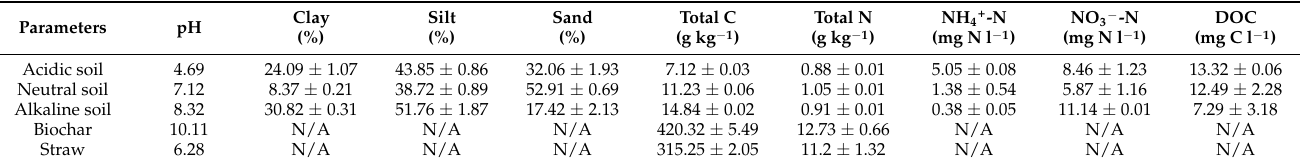
Table 1. The initial physical and chemical characteristics of soils, maize straw, and corn biochar.